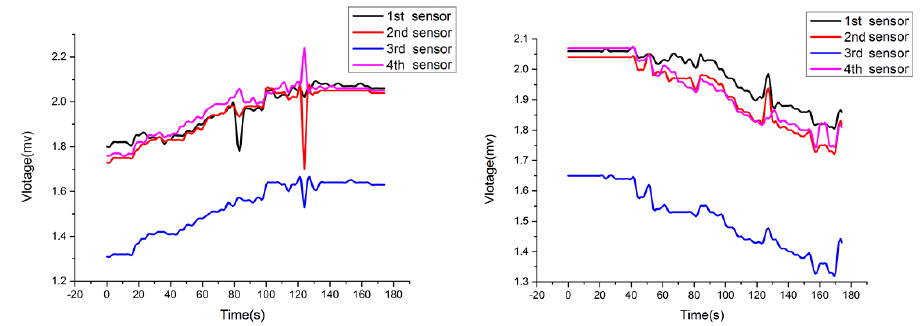
Figure 22. Tension curves of four wire ropes when a valve is closed.